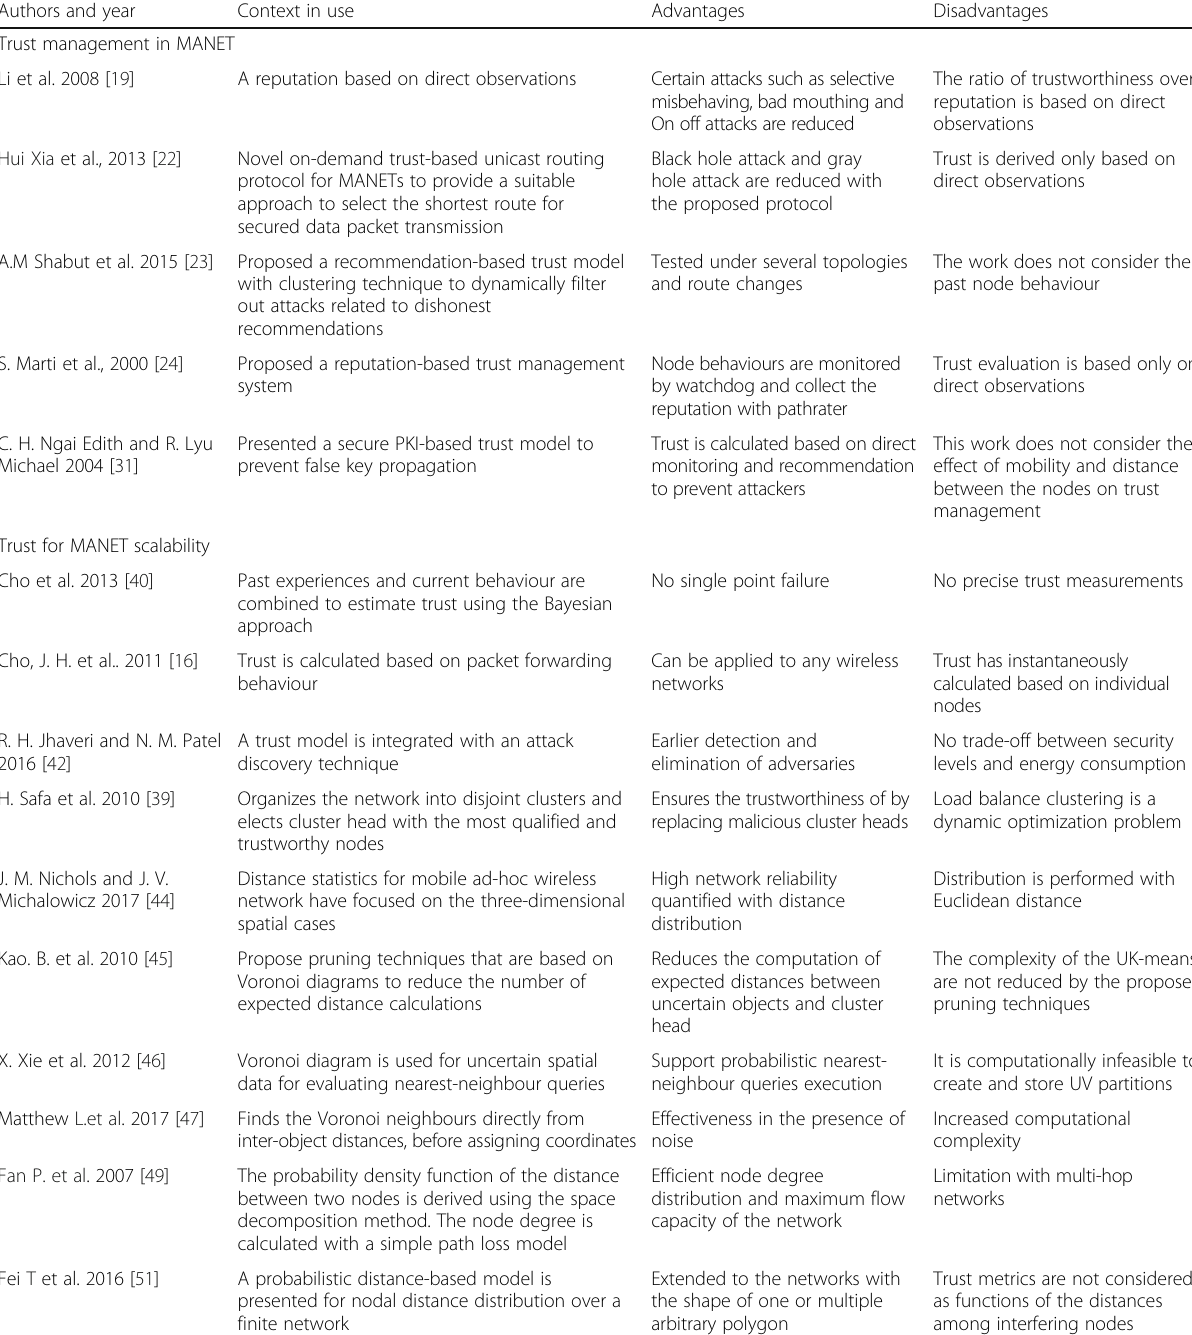
Table 1 Comparison of different trust